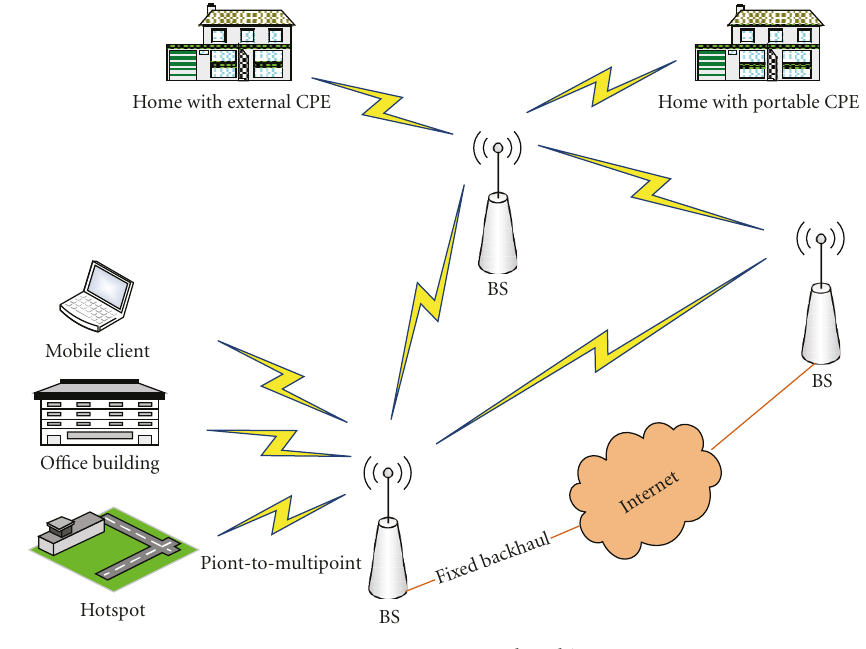
Figure 1: IEEE 802.16 network architecture.